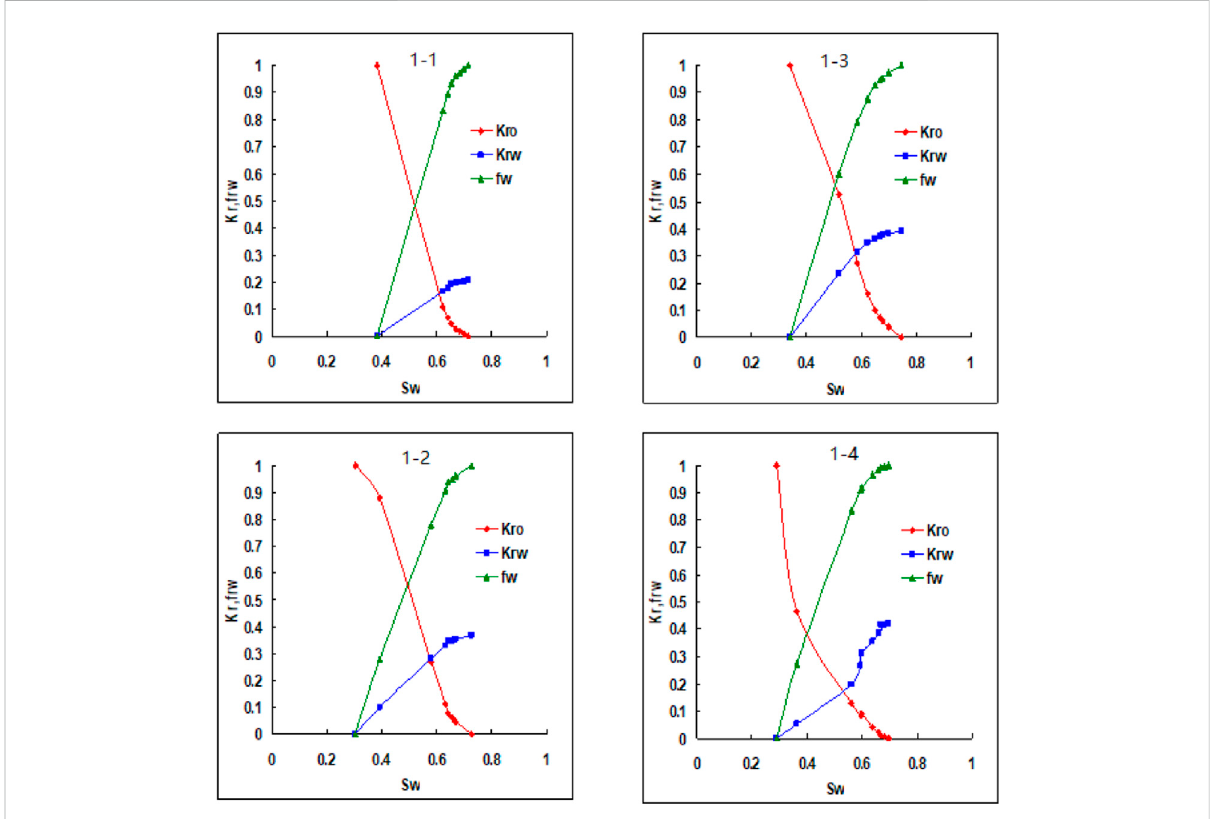
FIGURE 15 Oil – water relative permeability curves of cores before and after being fractured.